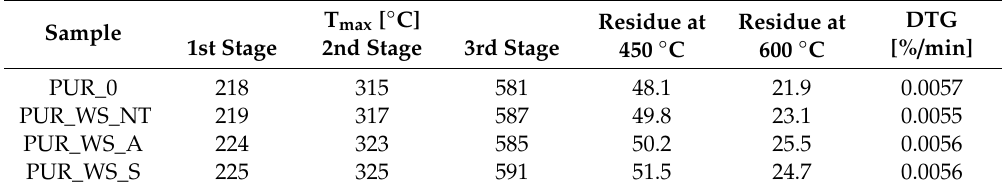
Table 6. Thermogravimetric analysis (TGA) results.